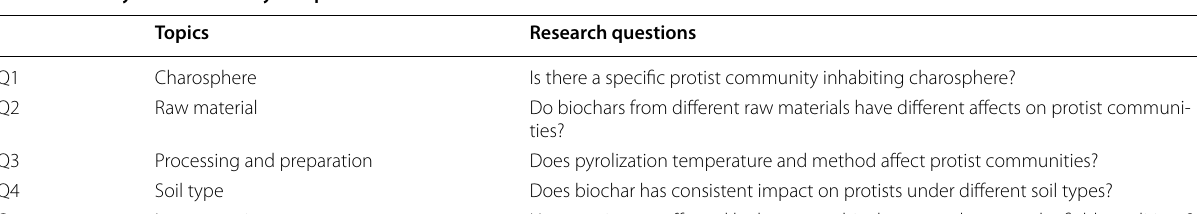
Table 2 Key questions highlighting important topics on biochar-protist research Protist diversity and community composition